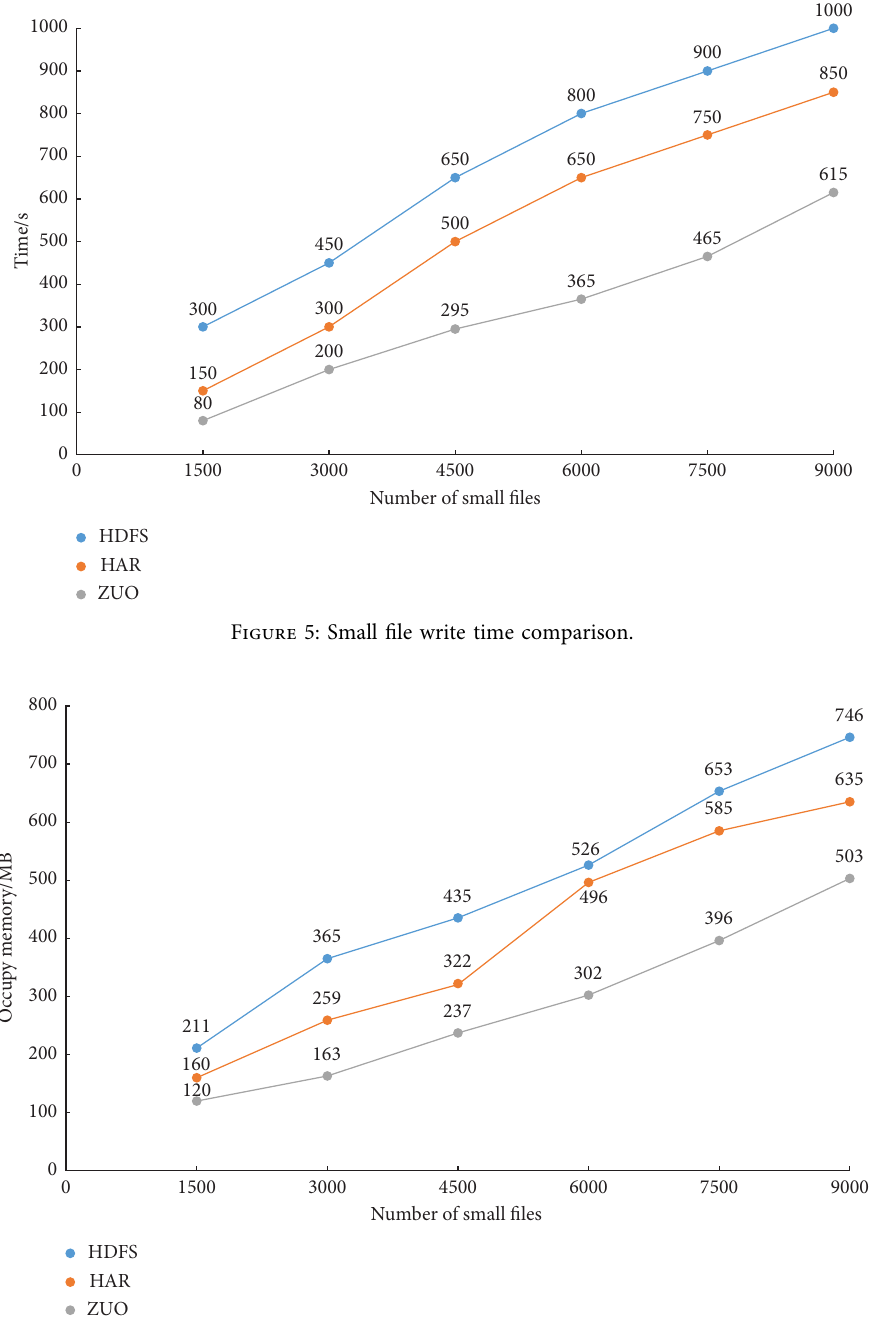
Figure 6: Namenode memory